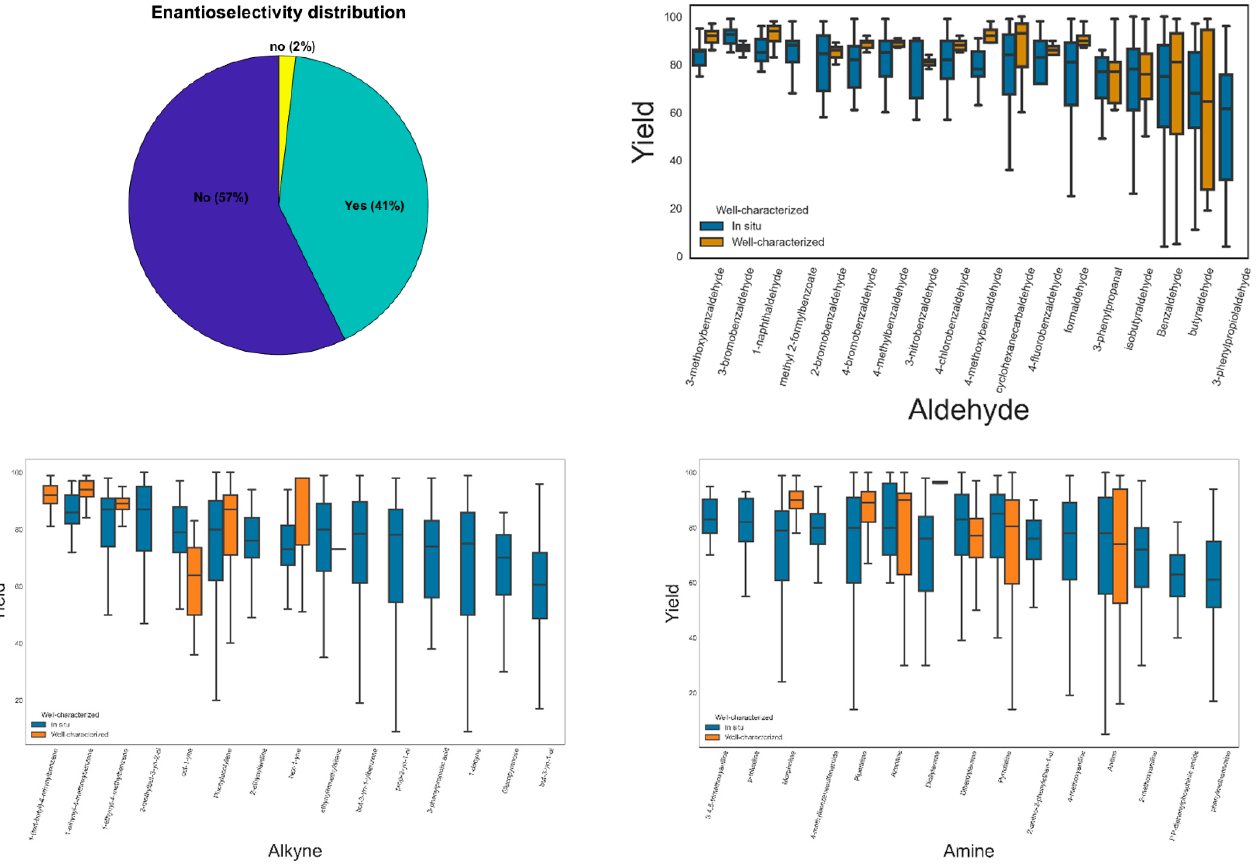
Figure 16. ( upper left ) Enantioselectivity distribution in 2376 entries. ( upper right ) Yield comparison of aldehydes between well-characterised—in situ. ( lower ) Yield comparison of alkynes between well-characterised—in situ ( left ); Yield comparison of amines between well-characterised—in situ ( right ).